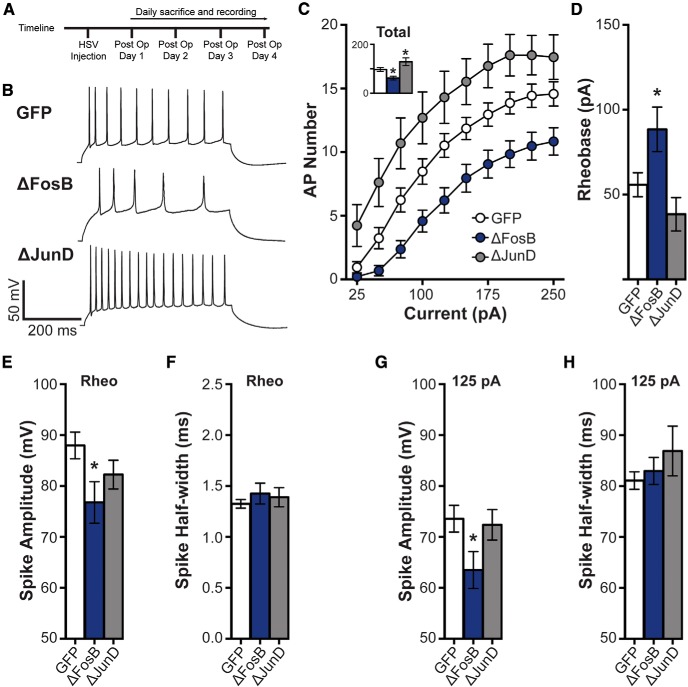
ΔFosB regulates spike number in hippocampal CA1 neurons. A, Experimental timeline. B, Representative spikes from 125 pA depolarizing current injection in dHPC CA1 neurons transduced by HSV-GFP (GFP), HSV-GFP+ΔFosB (ΔFosB), and HSV-GFP + ΔJunD (ΔJunD). C, Spike (AP) number across increasing depolarizing current steps (25–250 pA) for GFP (n = 21 cells; n = 8 mice), ΔFosB (n = 19 cells; n = 9 mice), and ΔJunD (n = 14 cells; n = 5 mice). The number of APs was significantly decreased by ΔFosB, and increased by ΔJunD. *p < 0.05, **p < 0.01 (two-way repeated-measures ANOVA; Holm–Sidak comparisons). Inset, Total number of APs across all steps. Total spikes were similarly regulated by ΔFosB. *p < 0.05 (one-way ANOVA; Holm–Sidak comparisons). D, Rheobase (in pA) in GFP-, ΔFosB-, and ΔJunD-expressing cells. Rheobase was significantly increased by ΔFosB expression. *p < 0.05 (one-way ANOVA; Holm–Sidak comparisons). E, Rheobase spike peak amplitude (in mV). Spike amplitude was significantly decreased by ΔFosB expression. *p < 0.05 (one-way ANOVA; Holm–Sidak comparisons). F, Rheobase spike half-width (in ms). No differences were observed. G, Mean spike amplitude (in mV) elicited by 125 pA depolarizing current injection. Spike amplitudes at 125 pA current were significantly decreased by ΔFosB expression. *p < 0.05 (one-way ANOVA; Holm–Sidak comparisons). H, Mean spike half-width (in ms) elicited by 125 pA depolarizing current injection. No differences were observed. All graphs display means ± SEM.